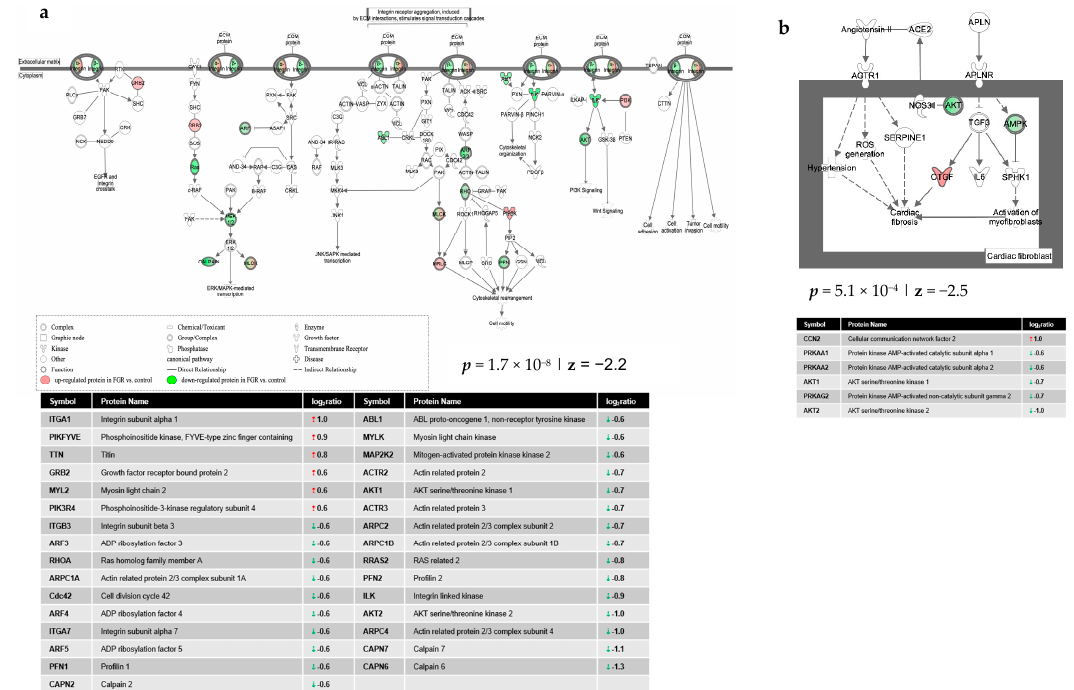
Nutrients 2021 , 13 , x FOR PEER REVIEW Figure 2. Ingenuity Pathway Analysis of differentially expressed proteins in FGR compared to control showed ( a ) decreased integrin signaling and ( b ) decreased apelin cardiac fibroblast signaling pathway.